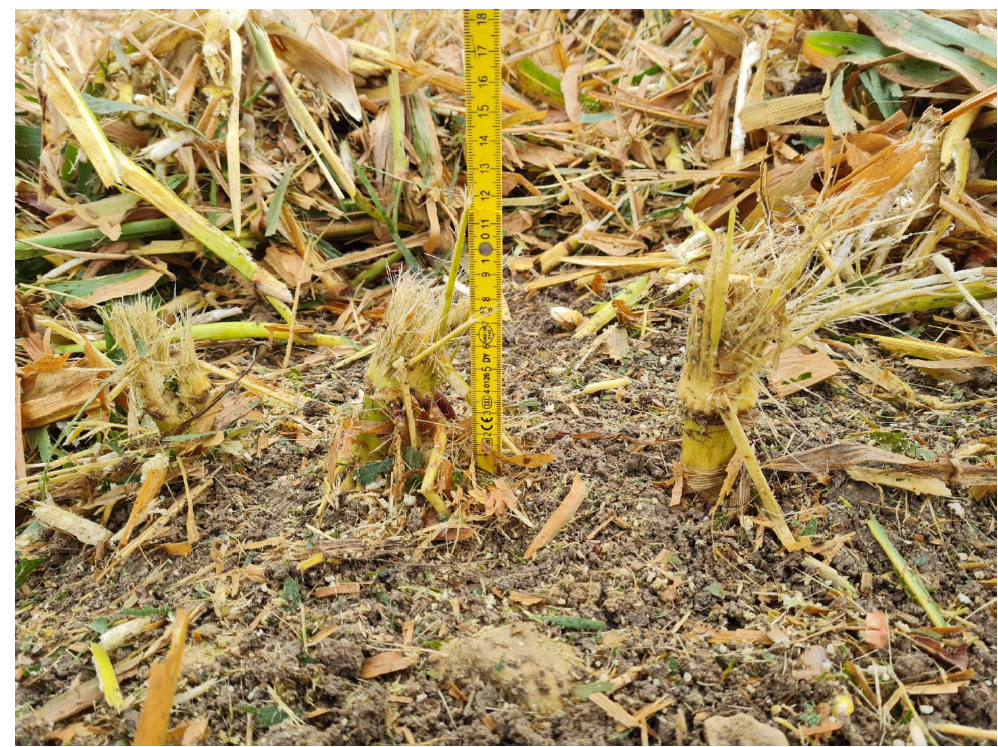
Figure A3. Corn stubble processed by the corn header equipped with flail knives (cutting height level 1).